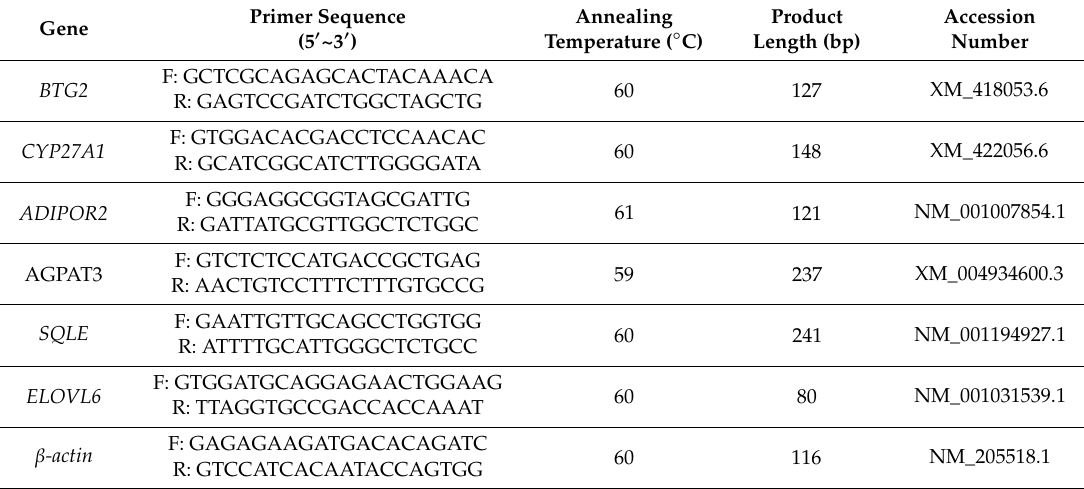
Table 2. Primer sequences used for